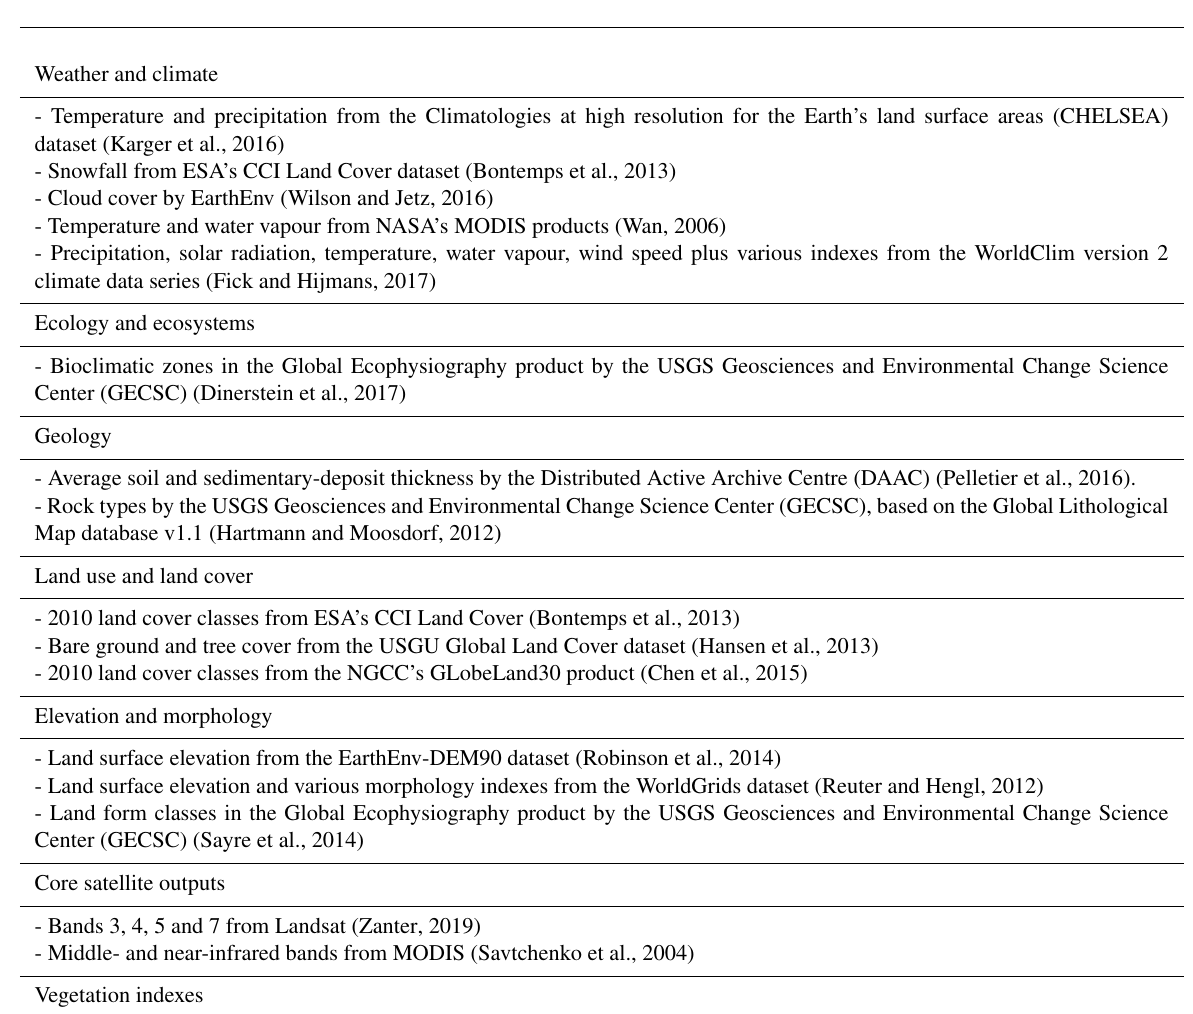
Table A1. Covariate sets and